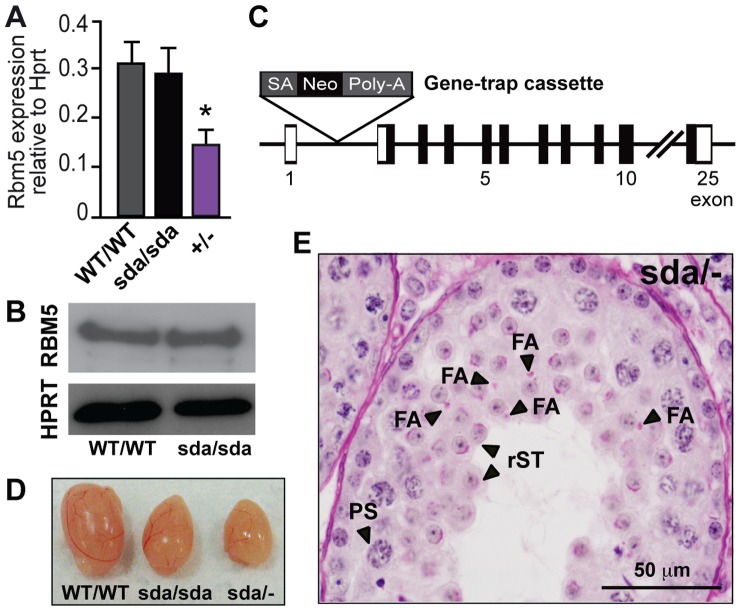
The R263 mutation results in the generation of a loss-of-function allele.(A) Rbm5 mRNA expression in the Rbm5WT/WT, Rbm5sda/sda and Rbm5+/− (heterozygous knockout) postnatal day 28 testes, as determined by qRT-PCR analysis and normalised to Hprt expression. (B) RBM5 protein in postnatal day 28 testes of the Rbm5WT/WT and Rbm5sda/sda mice. HPRT was used as loading control. (C) Schematic of the Rbm5 gene-trap knockout allele. SA: splice acceptor site, Neo: neomycin resistant marker, Poly-A: polyadenylation signal (D) Testicular atrophy in the Rbm5sda/− (compound heterozygous) and Rbm5sda/sda males compared to an Rbm5WT/WT littermate. (E) Periodic acid-Schiff stained testis section of a 10-week-old adult Rbm5sda/− male. PS: pachytene spermatocyte, rST: round spermatid; FA: fragmented acrosomes.